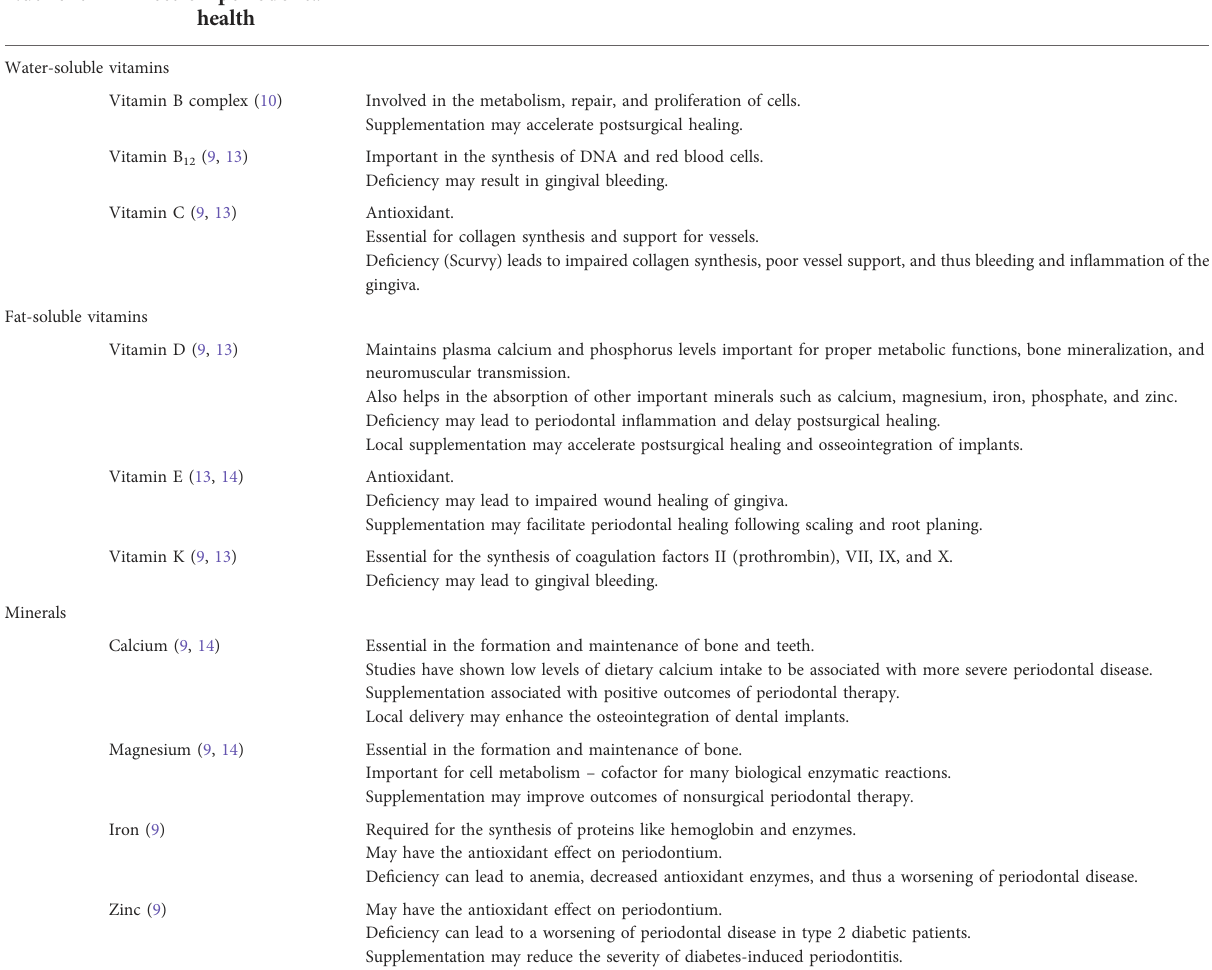
TABLE 1 Effect of nutrients on the health of the periodontium. Nutrient Effect on periodontal